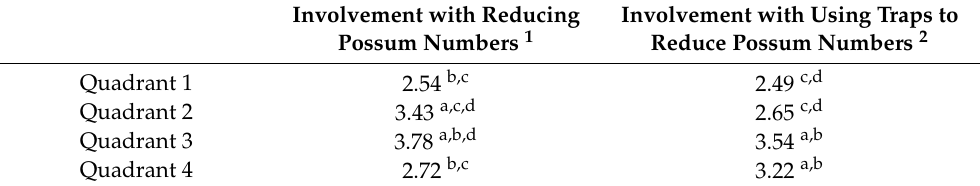
Table 2. Mean involvement by I 3 quadrant.